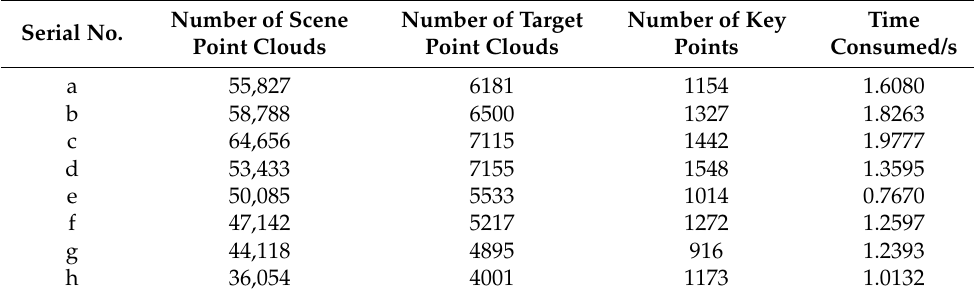
Table 1. Point cloud processing process. Serial